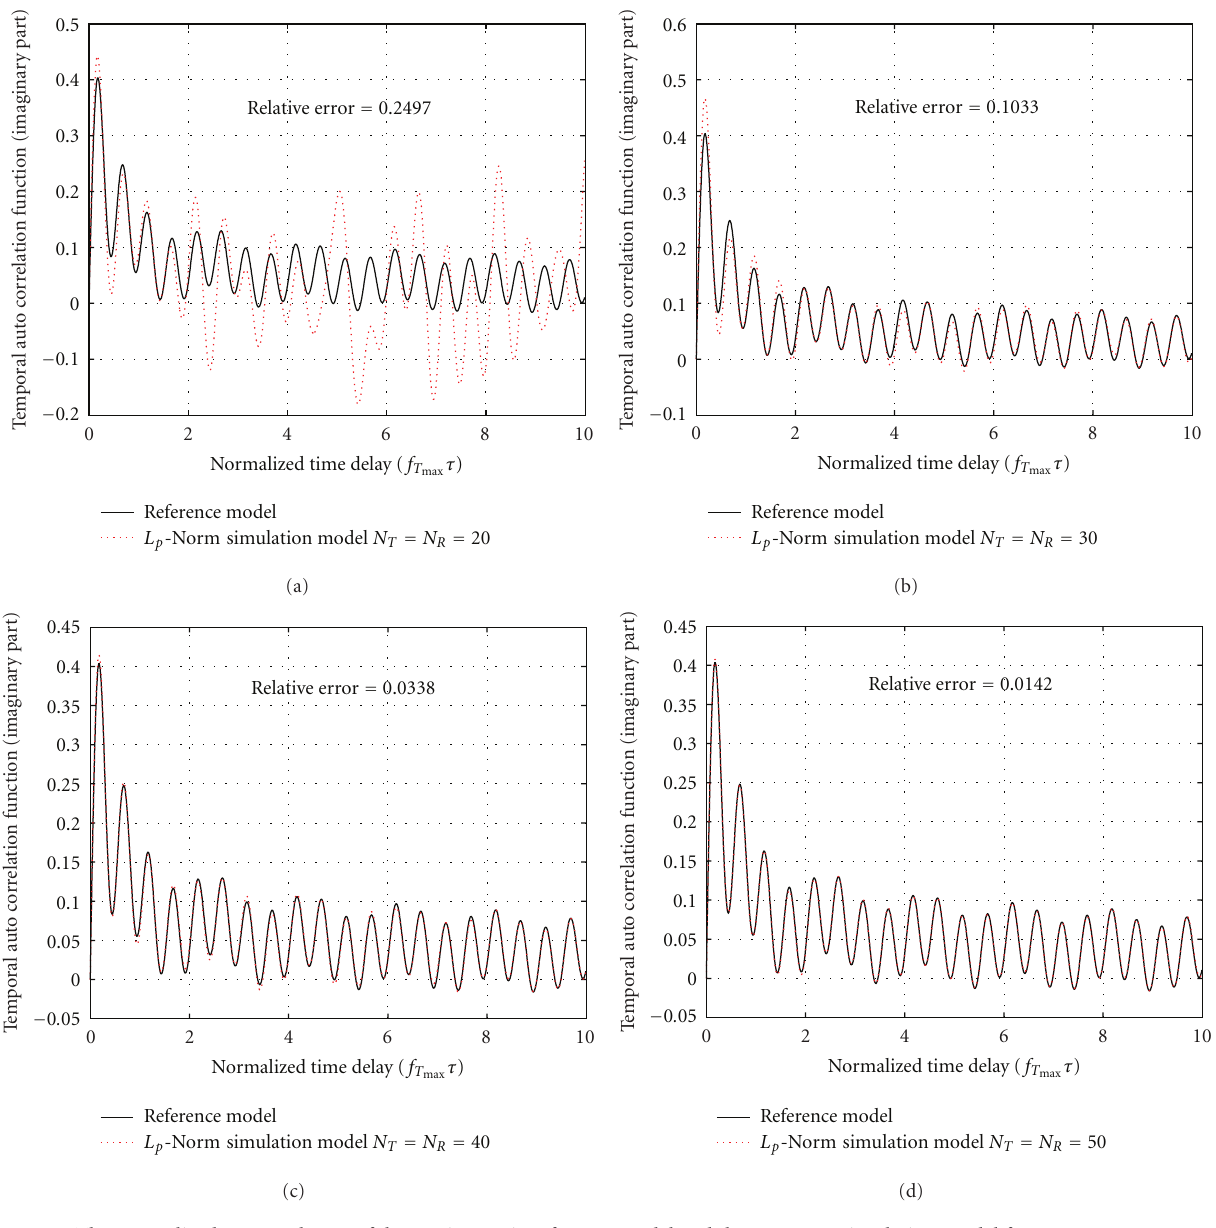
Figure 5: The normalized temporal ACF of the nonisotropic reference model and the L p -Norm simulation model for N T = N R = 20, 30, 40, 50 (imaginary part).